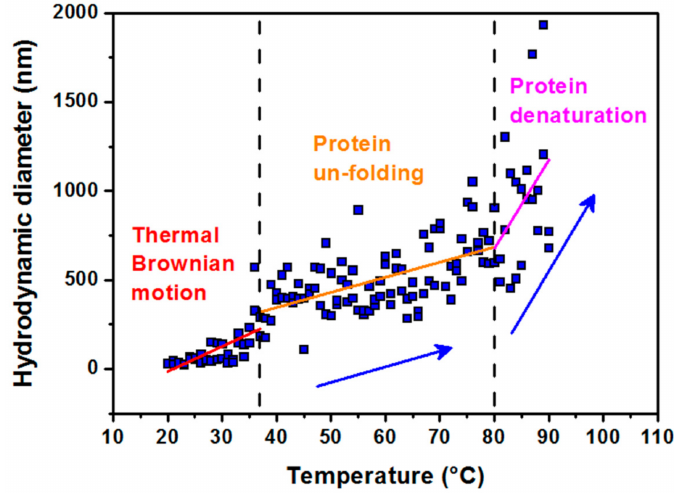
Figure 1. Hydrodynamic diameter dependence vs. temperature of the solutions. Data were obtained in the range from 20 to 90 ◦ C for a colloidal solution of apoferritin in AMPSO buffer at pH 8.6, showing three characteristic modes of apoferritin conformation. The first region of 20–37 ◦ C (physiological temperature) refers to the thermal Brownian motion of apoferritin particles. The second region of 37–80 ◦ C shows the protein unfolding behavior and the third one above 80–90 ◦ C illustrates the protein denaturation